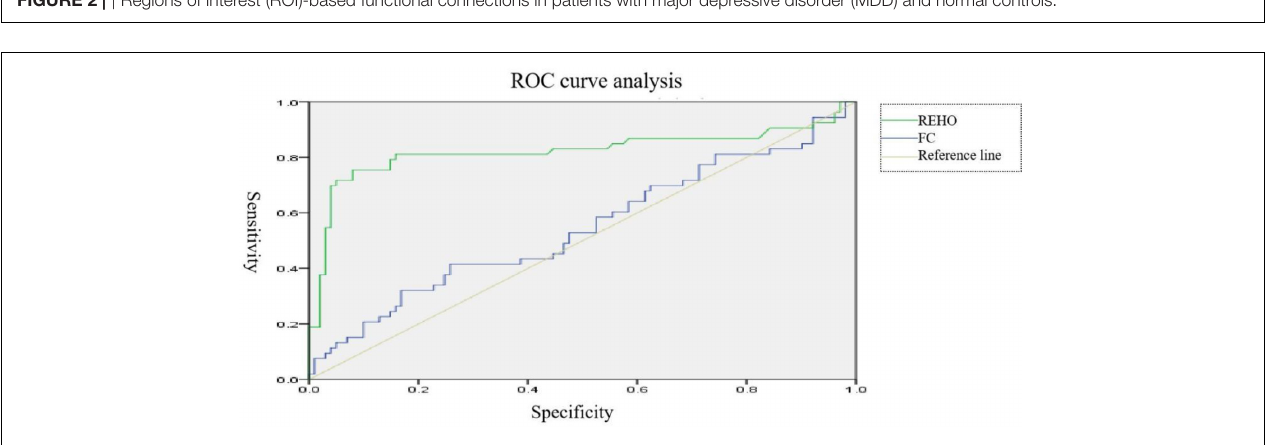
FIGURE 2 | | Regions of interest (ROI)-based functional connections in patients with major depressive disorder (MDD) and normal controls.